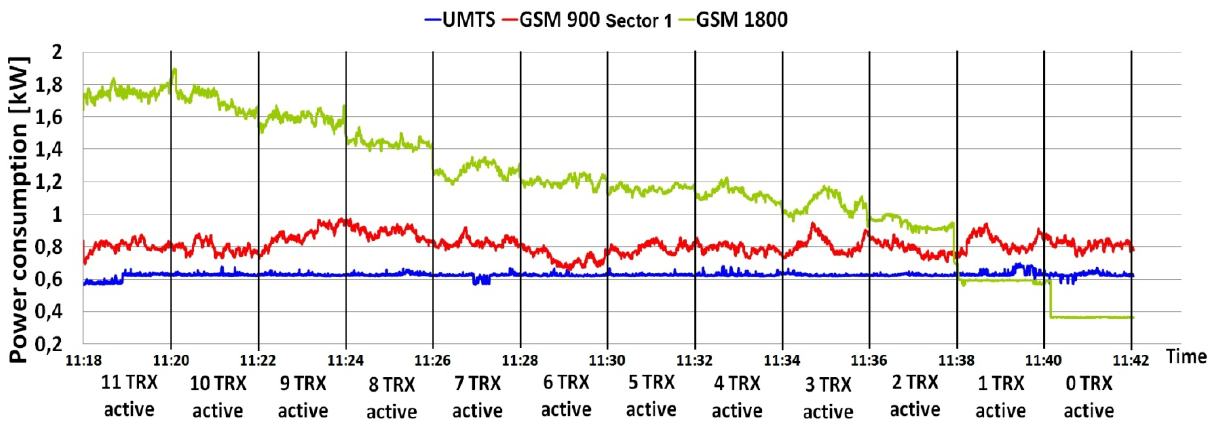
Figure 12. Power consumption of BSs during deactivation of TRXs in GSM 1800 BS